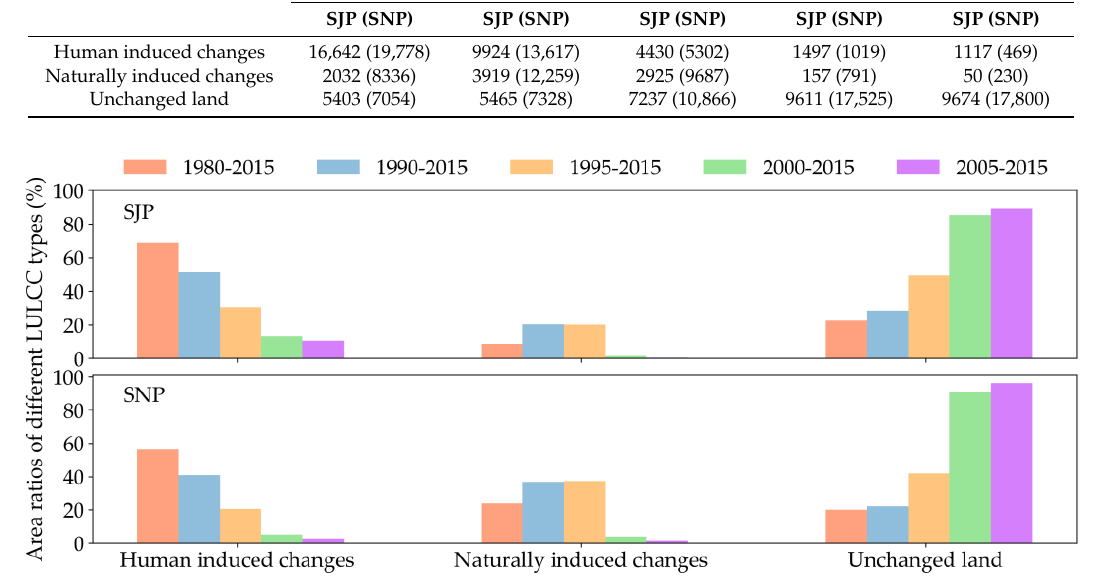
Figure 3. Areal ratio variations of LULCC types over the SJP and SNP for the five different periods.